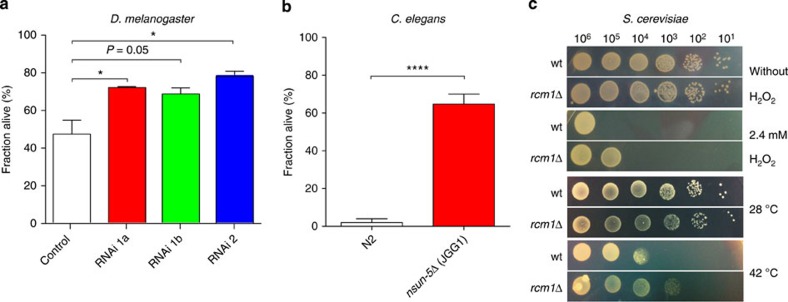
Reduced availability of NSUN5 increases stress resistance of model organisms.(a) Flies harbouring two individual RNAi constructs of dNsun5 in three lines show increased survival compared with control, when subjected to heat shock (4 h at 37 °C, N=100, two biological replicates, one-way ANOVA with Dunnett’s post test, α=0.05, *P<0.05). Error bars represent s.e.m. (b) nsun-5 mutant worms (JGG1) subjected to 20 mM paraquat treatment for 3 days show significantly increased resistance to the drug (four plates with 30 worms each per genotype, two-sided Student’s t-test, ****P<0.0001). Error bars represent s.e.m. (c) Yeast serial dilution growth assays demonstrate increased resistance of rcm1Δ cells to H2O2 (upper panel) and to heat shock (lower panel). Uncropped pictures of the entire plates are given in Supplementary Fig. 5.